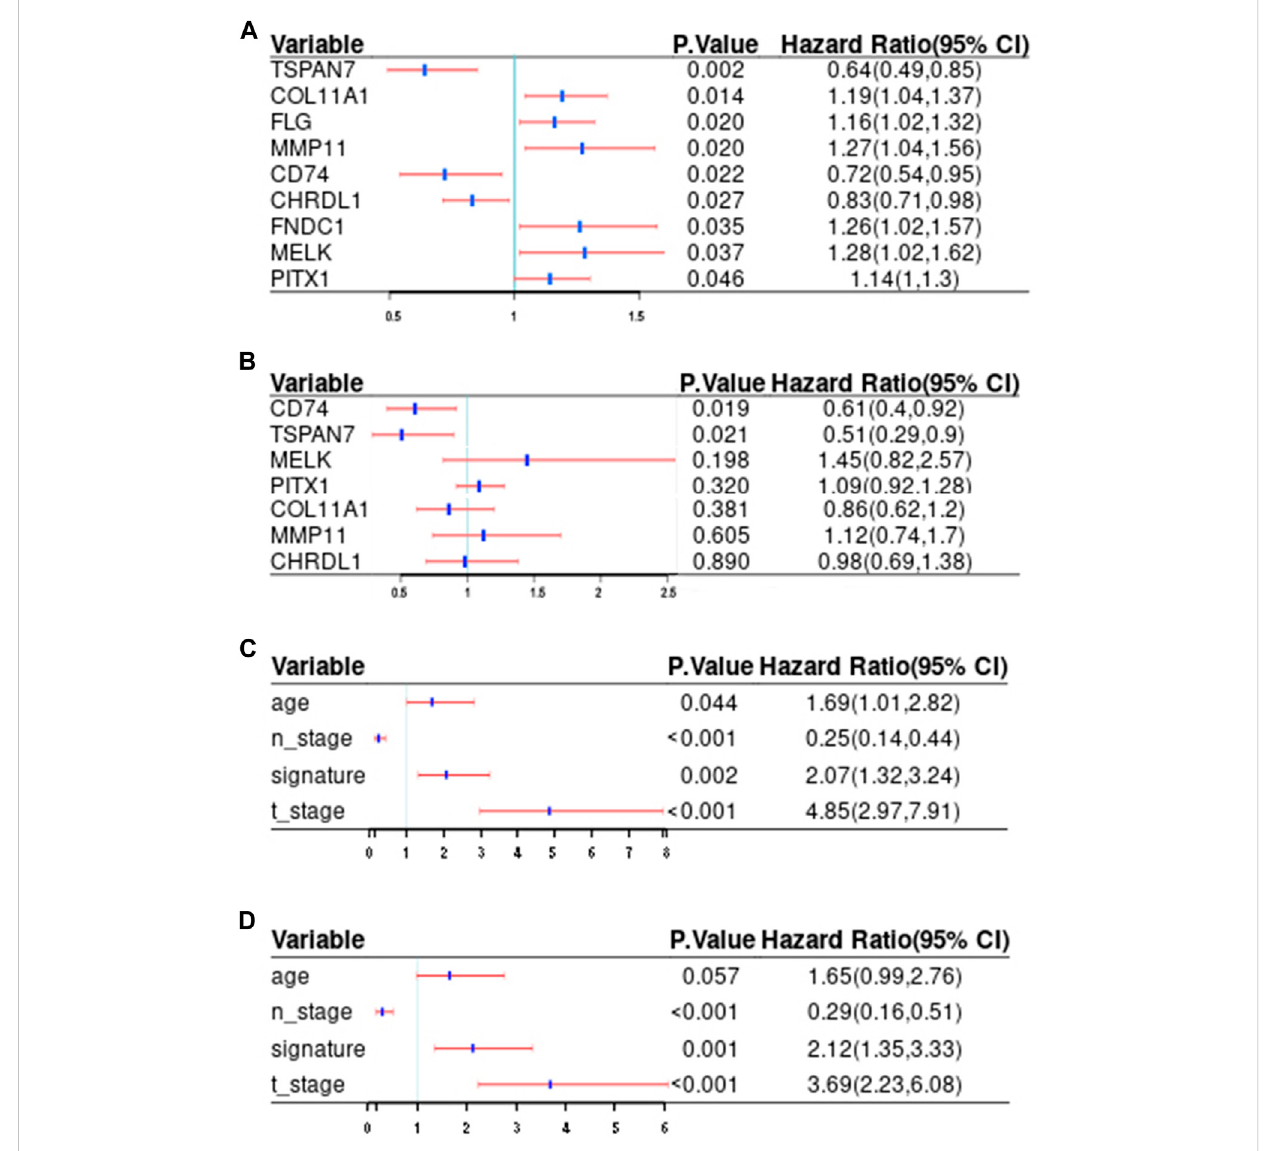
FIGURE 3 Screening of potential prediction biomarkers and risk factors for distant metastasis. (A, B) Univariate (A) and multivariate (B) Cox regression analysis of themetastasis-related genes. (C, D) Univariate (C) and multivariate (D) Cox regression analysis of correlations betweenthe signature and clinical traits. Red and blue, respectively indicate 95% con fi dence interval and hazard ratio. T_stage, tumor size; N_stage, nodal status; Signature, the risk